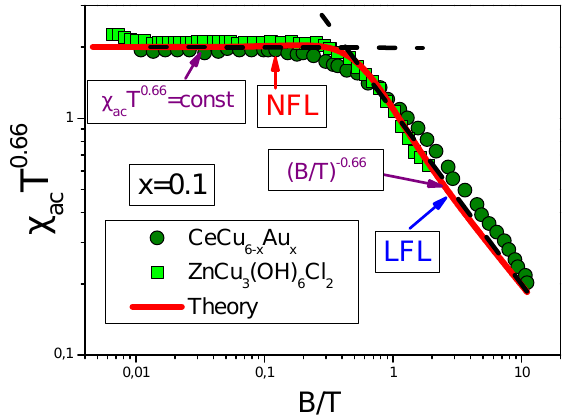
Figure 6. The universal scaling behavior of different strongly correlated Fermi systems versus B / T . The universal behavior of the HF metal CeCu 6 x Au x is extracted from data [63], and that of − ZnCu 3 ( OH ) 6 Cl 2 is derived from data [16]. At B / T 1 the systems exhibit the NFL behavior, that is (cid:28) T 2/3 χ ∝ const . At B / T 1 the systems demonstrate the LFL behavior, with χ being a decreasing (cid:29) function of B / T .